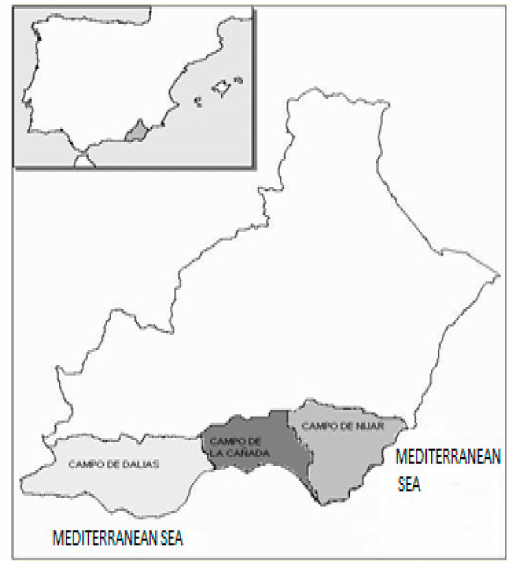
Figure 1. Location of Almeria and its productive zones of cultivation under plastic.